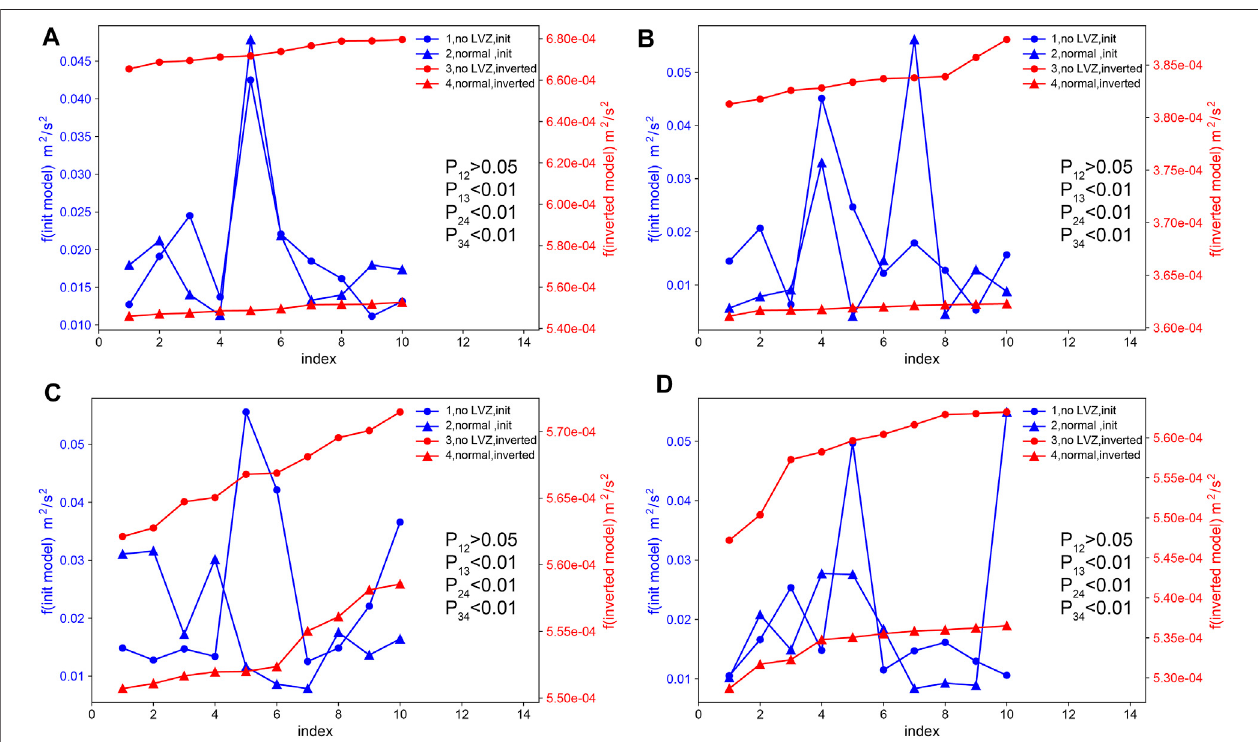
FIGURE12| Objectivefunctionvaluesofthemodelsandtheresultsofthestatisticalsigni fi cancetest.Theblueandredlinesdenotetheobjectivefunctionvaluesof theinitialmodelsandinversionmodels,respectively.Thetrianglesandcirclesdenotetheinversionthatallowsthevelocitytodecreaseandtheinversionthatprohibitsthe velocity from decreasing, respectively. (A) TH array; (B) ZV array; (C) subarray 1; (D) subarray 2